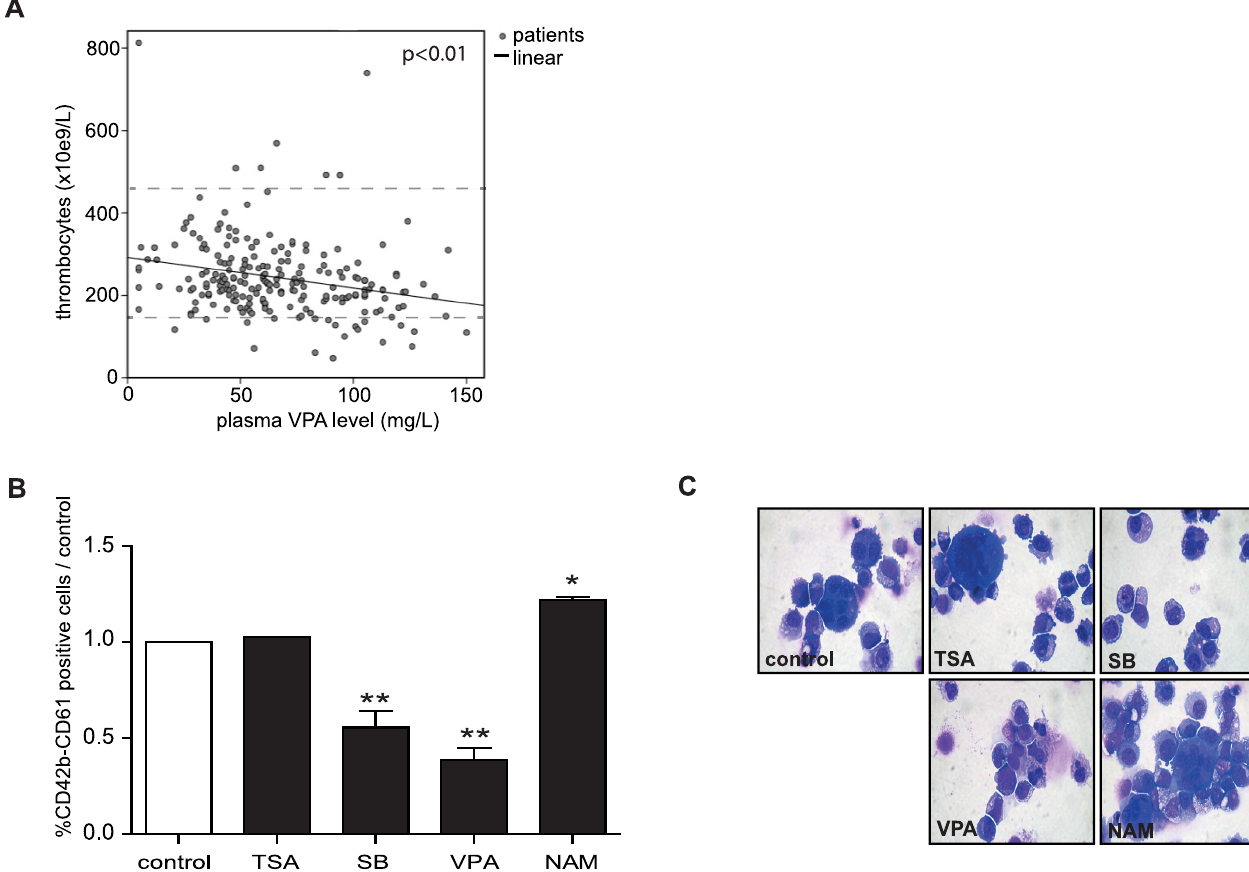
Fig 1. KDACi treatment differentially modulates megakaryocyte development. (A) From the peripheral blood the absolute number of platelets was analysed in patients treated with VPA (n = 217) together with plasma VPA concentration, measured at the same day. Data represent linear regression analysis of the absolute number of platelets (dependent variable), and plasma VPA concentration (independent variable). (B) UCB-derived CD34+ cells were differentiated towards megakaryocytes in the absence or presence of 10nM TSA, 250 μ M SB, 200 μ M VPA, or 1mM NAM for 11 days. Differentiation was determined based on the surface expression of CD61 and CD42b (percentage of double positive cells compared to the control), and (C) cytospin analysis. Data are representative for 3 independent experiments. Error bars represent SEM, (cid:3) p < 0.05, (cid:3)(cid:3) p < 0.01.